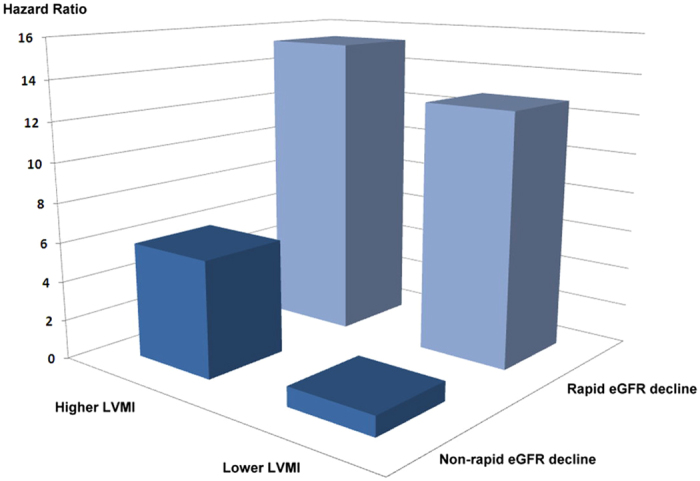
Synergistic effect of eGFR decline rate and LVMI on the prediction of the composite outcome.